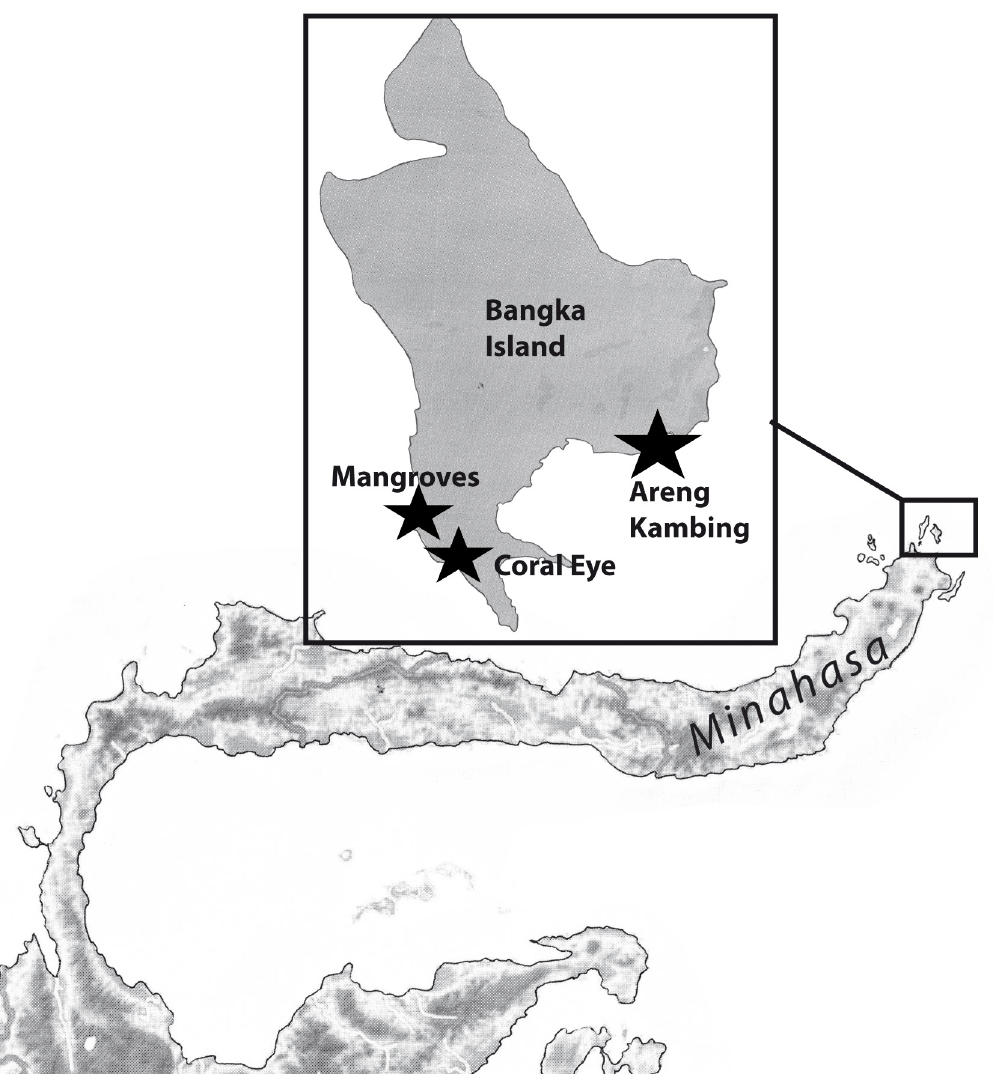
Fig. 1. Map of Northern Sulawesi with sampling sites on Bangka